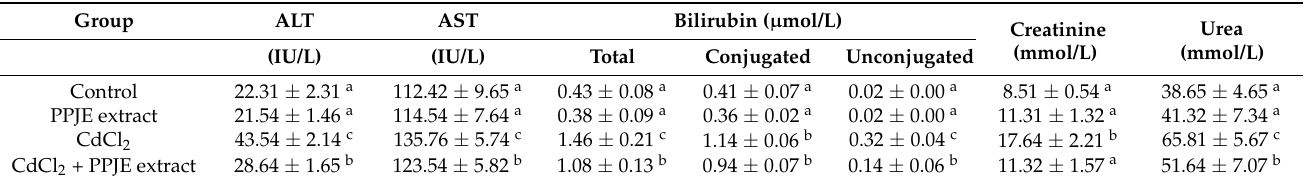
Table 3. Serum ALT, AST, bilirubin, urea, and creatinine of the studied groups. Control group. Juice extract (250 mg/kg)-treated rat kidney showing normal appearance of glomeruli. CdCl 2 (1 mg/kg)- treated rat kidney showing tubule glomerular degeneration. CdCl 2 + juice extract (250 mg/kg)- treated